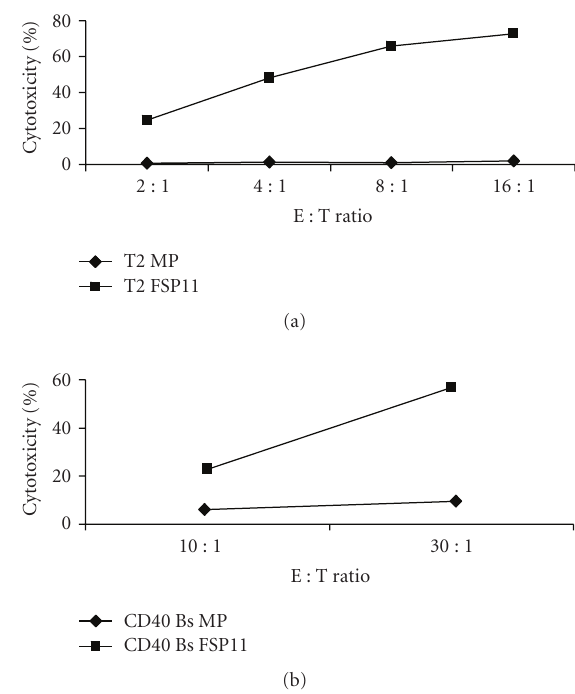
Figure 2: Analysis of cytotoxic potential of the FSP11-specific T cell bulk. FACSotox was performed using peptide-loaded (either FSP11 (square) or control peptide MP (diamond)) (a) T2 cells and (b) CD40 Bs as target cells. E ff ector bulk T cells were added at di ff erent e ff ector to target cell (E : T) ratios. A representative experiment of three is shown. Analysis was performed after a 6-hour incubation